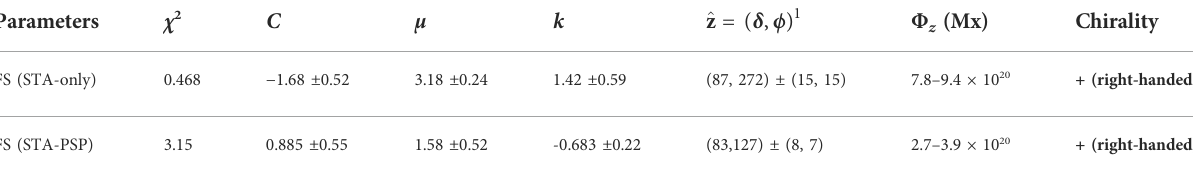
TABLE 1 Summary of geometrical and physical parameters for the ICME/MC from the FS model fi tting to the STA-only and combined STA-PSP spacecraft in-situ measurements. Parameters